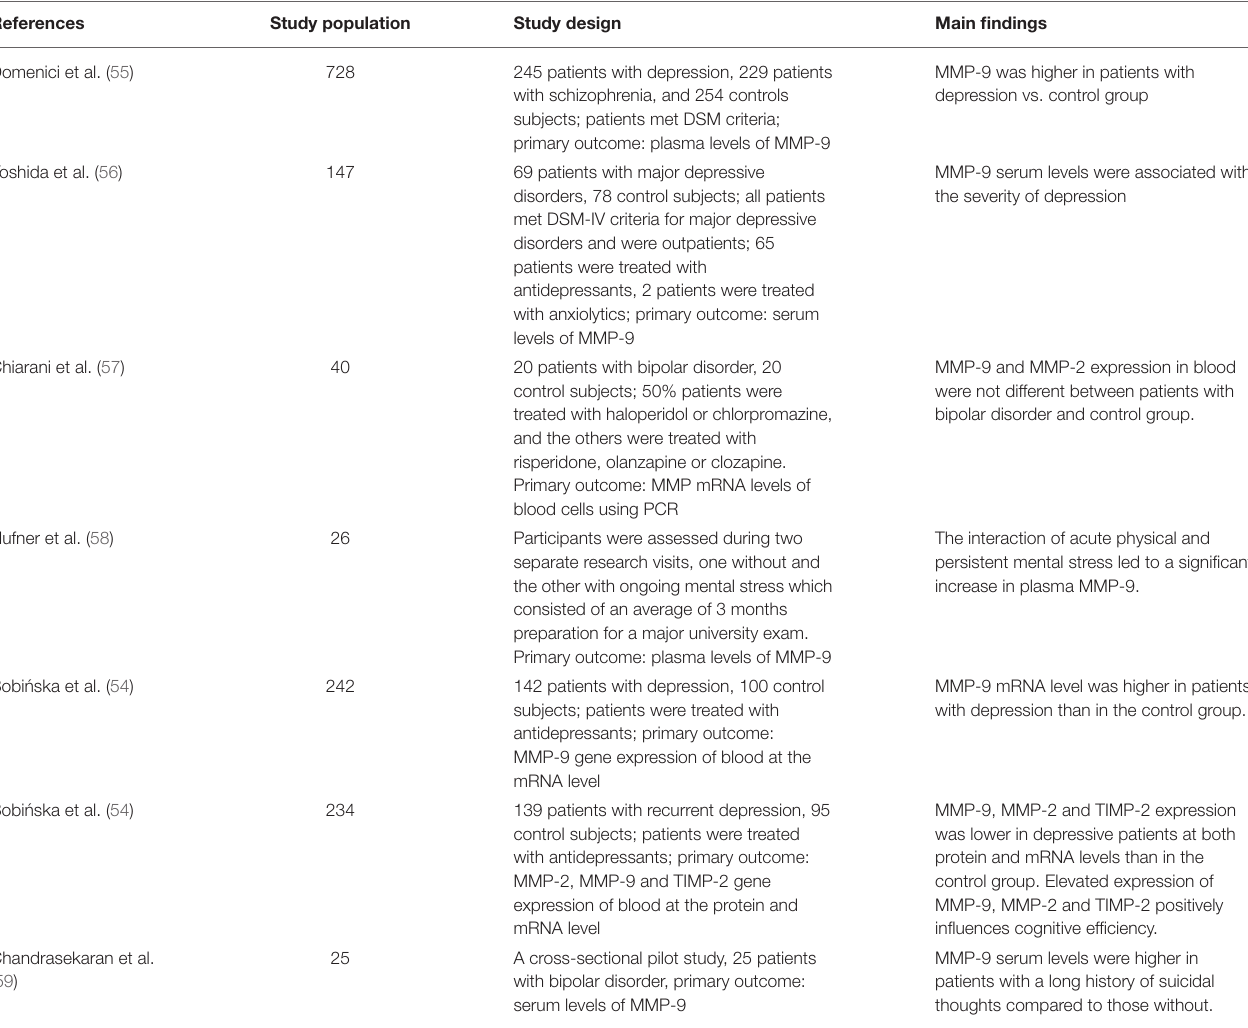
TABLE 1 | MMP-9 as a potential biomarker for depression—results from clinical